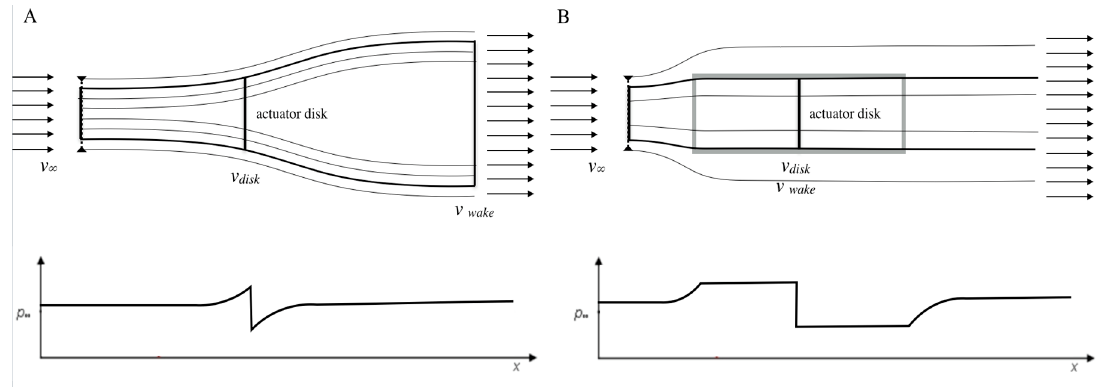
Figure 10. Relevant Pressure conditions: ( A ) Rankine – Froude Actuator Disk Theory and ( B ) Thrust Model.